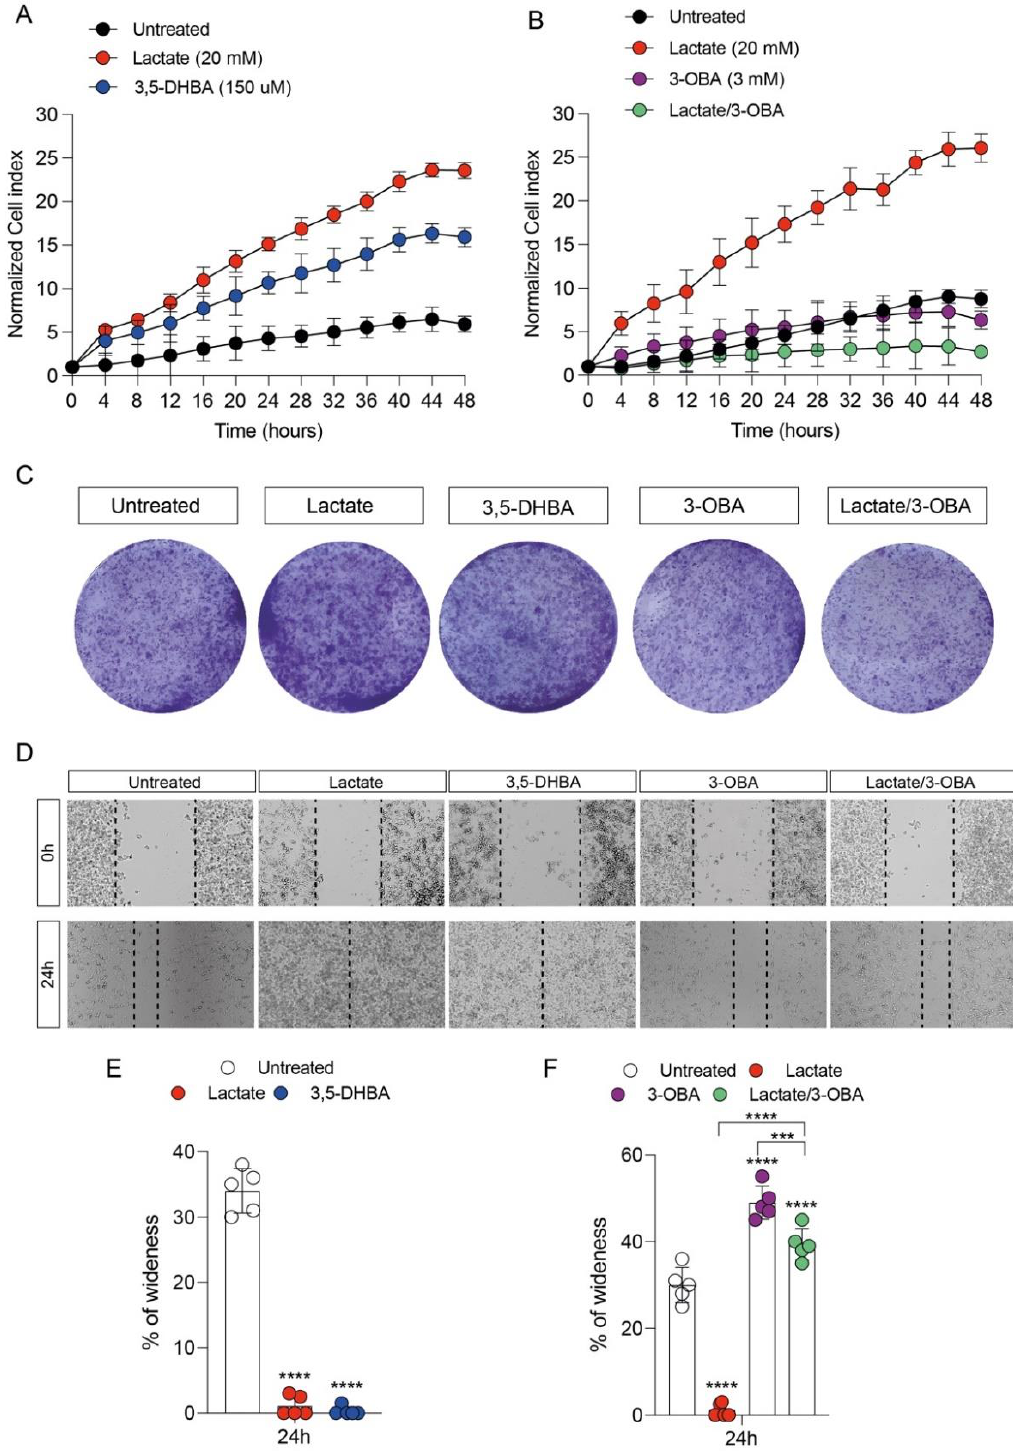
Figure 1. GPR81 stimulation promotes breast cancer cell growth. Effect of lactate (20 mM), 3,5-DHBA (150 µ M, GPR81 agonist) and 3-OBA (3 mM, GPR81 antagonist) on cell proliferation ( A , B ), colony formation capacity ( C ) and wound healing ( D – F ). Data are expressed as mean ± SD of at least four independent experiments. (*** p < 0.001; **** p <